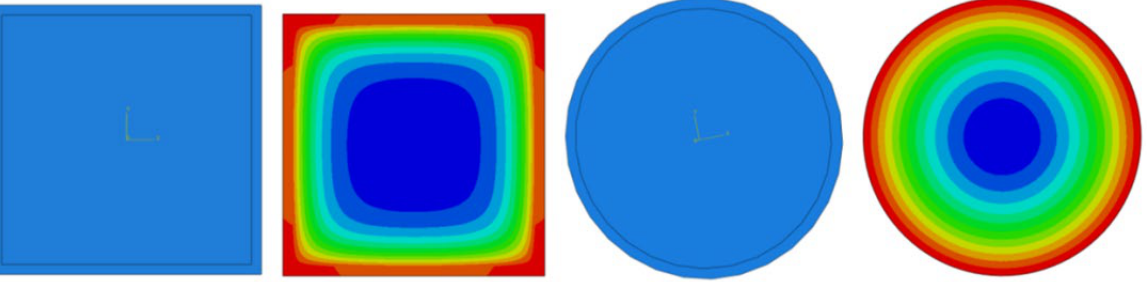
Figure 18. Illustration of the two-dimensional model with temperature